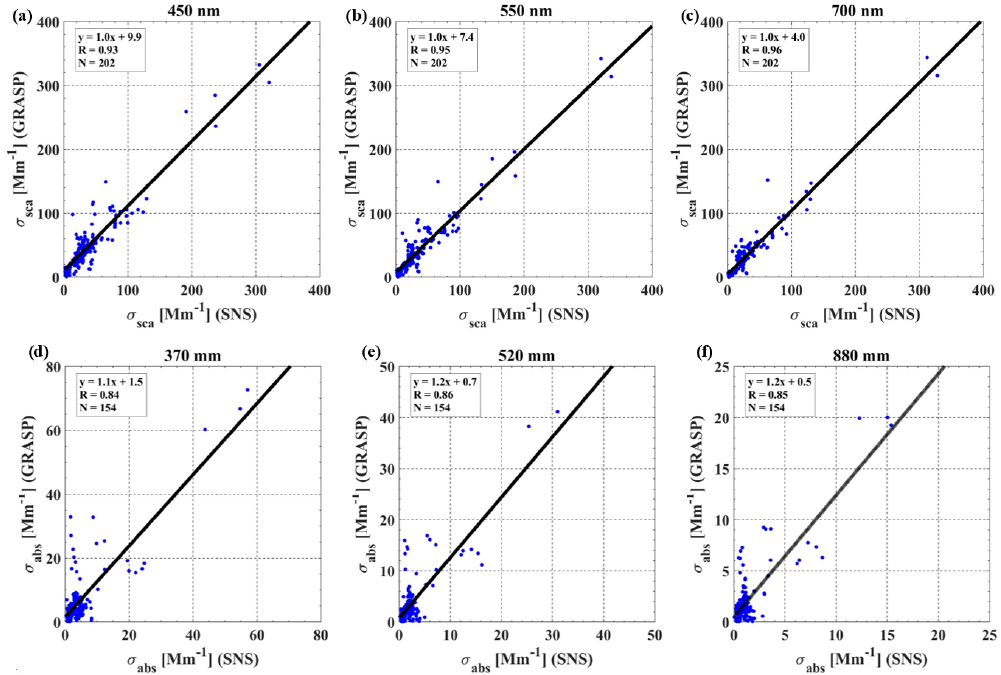
Figure 3. (a, b, c) Scattering ( σ sca ) and (d, e, f) absorption ( σ abs ) coefficients retrieved by GRASP at the SNS height versus in situ measure- ments at the